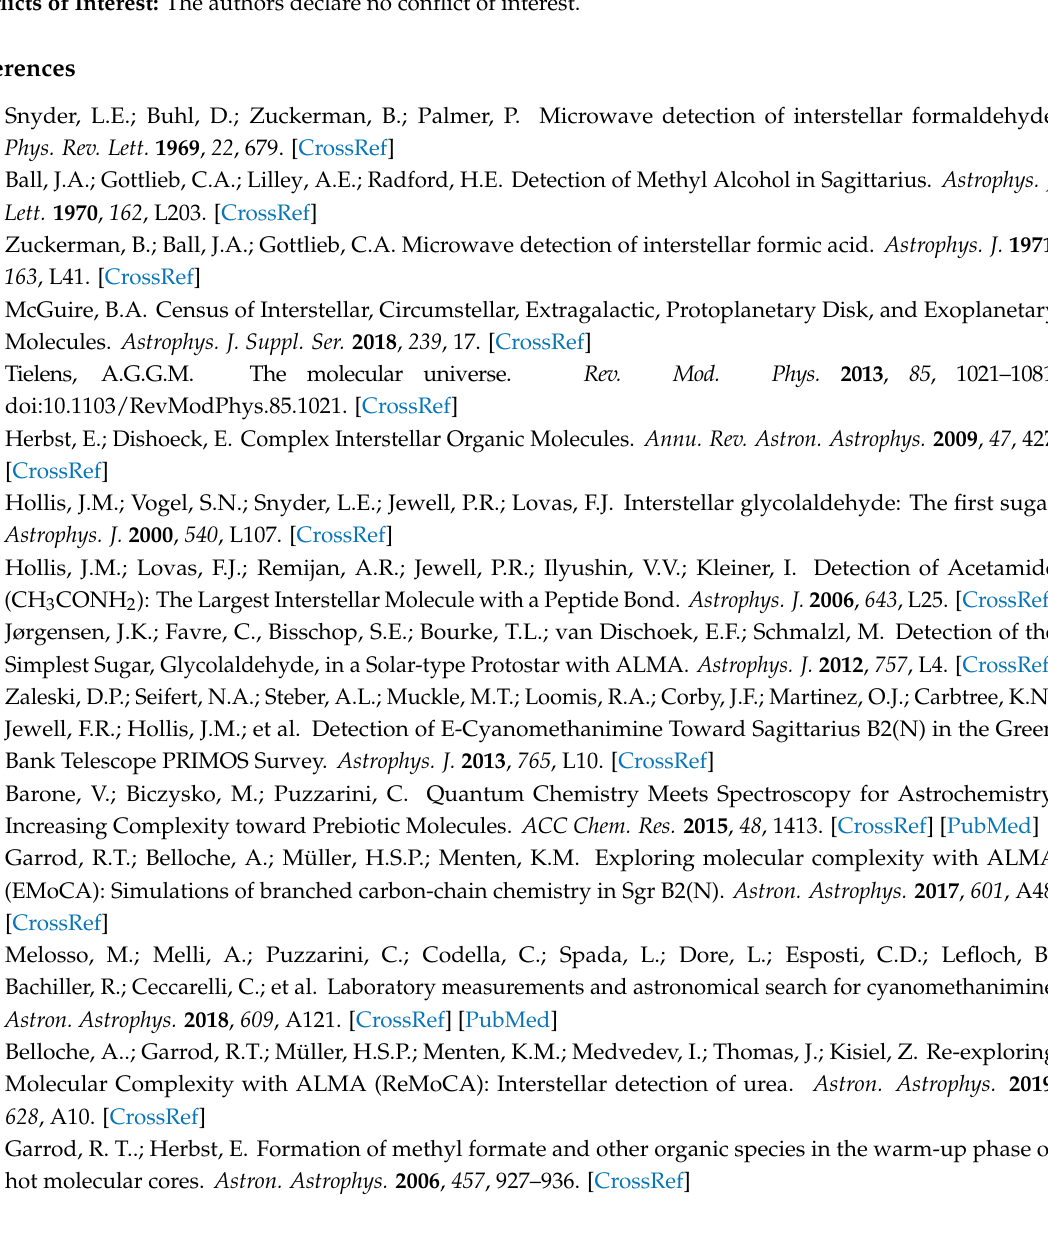
Supplementary Materials: The following are available online, Figure S1: Structures of the species appearing in the formation pathway of ethanimine as obtained at B2PLYP-D3(BJ)/aug-cc-pVTZ level of theory. Numeric labels are used for structural analysis in Table S1, Figure S2: Product branching ratios at various temperatures, Table S1: Structural parameters of the stationary points of the NH + C 2 H 5 reaction at different levels of theory. Distances are in Å, angles in ◦ , Table S2: Energies are in E h . Reference geometries at B2PLYP-D3(BJ)/aug-cc-pVTZ level of theory, Table S3: Coupled-cluster diagnostic for all the species T 1